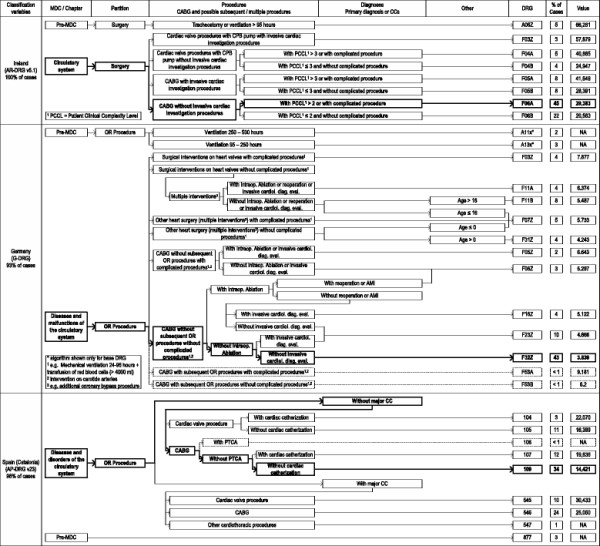
Grouping structure.